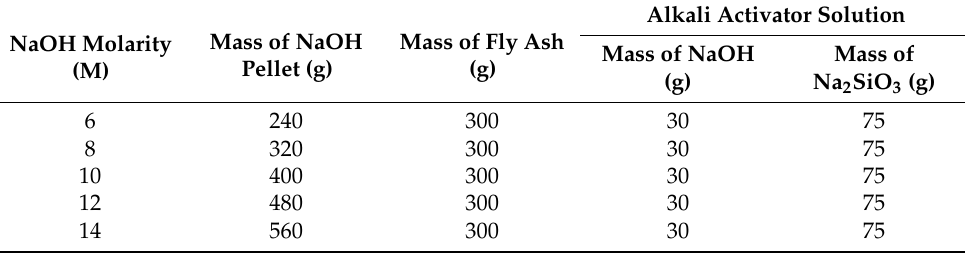
Table 2. Mixes of fly ash geopolymer aggregate with various NaOH molarities.